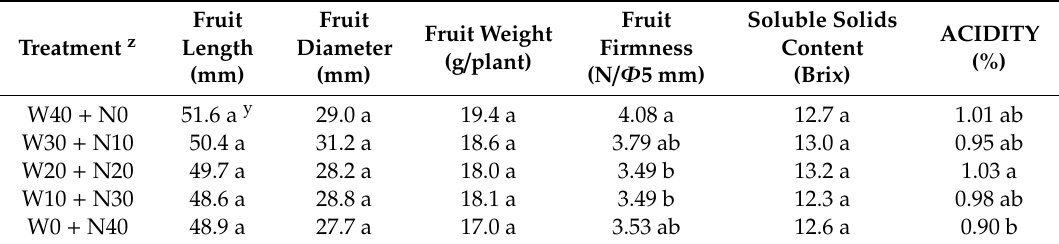
z Refer to Figure 1 for details on nutrient solution resupply periods. y Mean separation within columns by Tukey’s test at p ≤ 0.05.